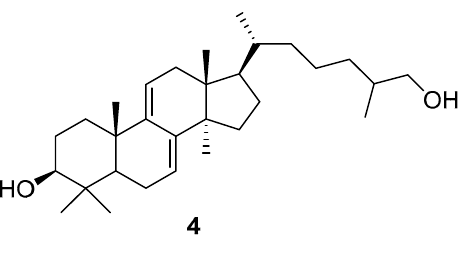
Figure 2. The structure of genoderol B ( 4